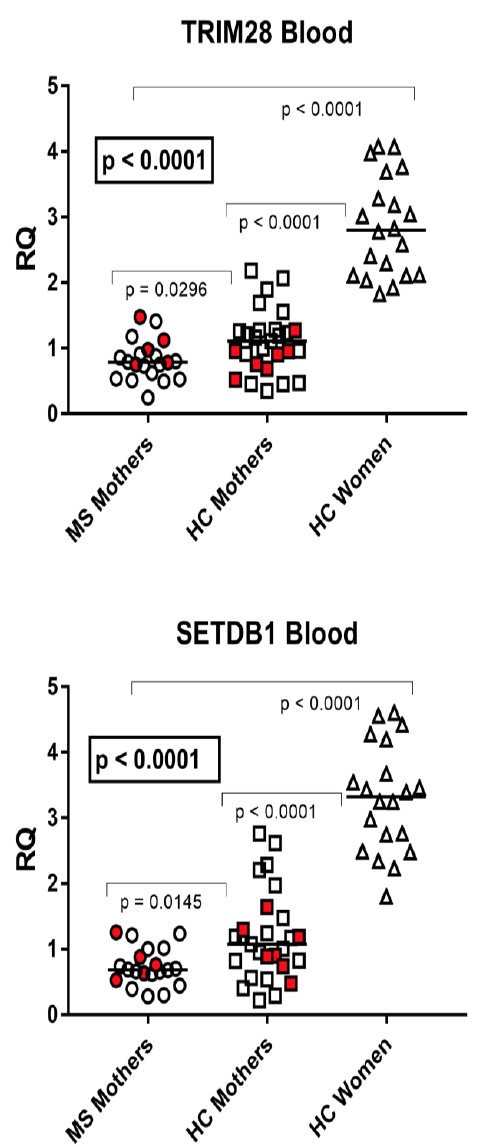
Figure 3. Expression of TRIM28 and SETDB1 in peripheral blood from 20 mothers with MS, 27 healthy control (HC) mothers, and 20 nonpregnant HC women of child-bearing age. RQ: relative quantification. Circles, squares, and triangles show the mean of three individual measurements; horizon- tal lines show the median values. Premature deliveries are in red. Medians and IQR 25–75%: TRIM28: Group A (mothers with MS) 0.78, 0.60–0.93; Group B (unaffected mothers) 1.11, 0.83–1.27; Group C2 (nonpregnant women) 2.80, 2.12–3.38; SETDB1: Group A 0.68, 0.60–0.91; Group B 1.07, 0.78–1.39; Group C2 3.32,